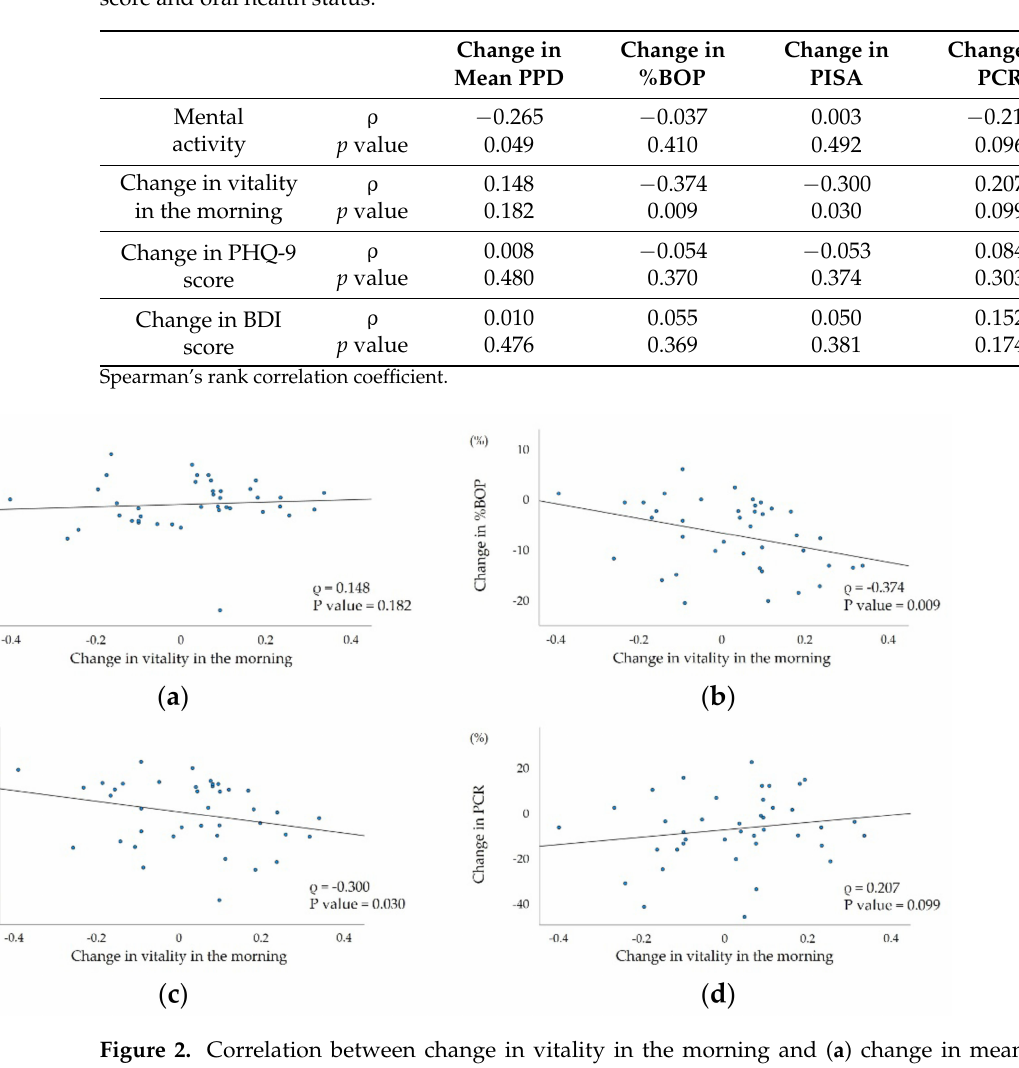
Figure 2. Correlation between change in vitality in the morning and ( a ) change in mean PPD; ( b ) change in %BOP; ( c ) change in PISA; and ( d ) change in